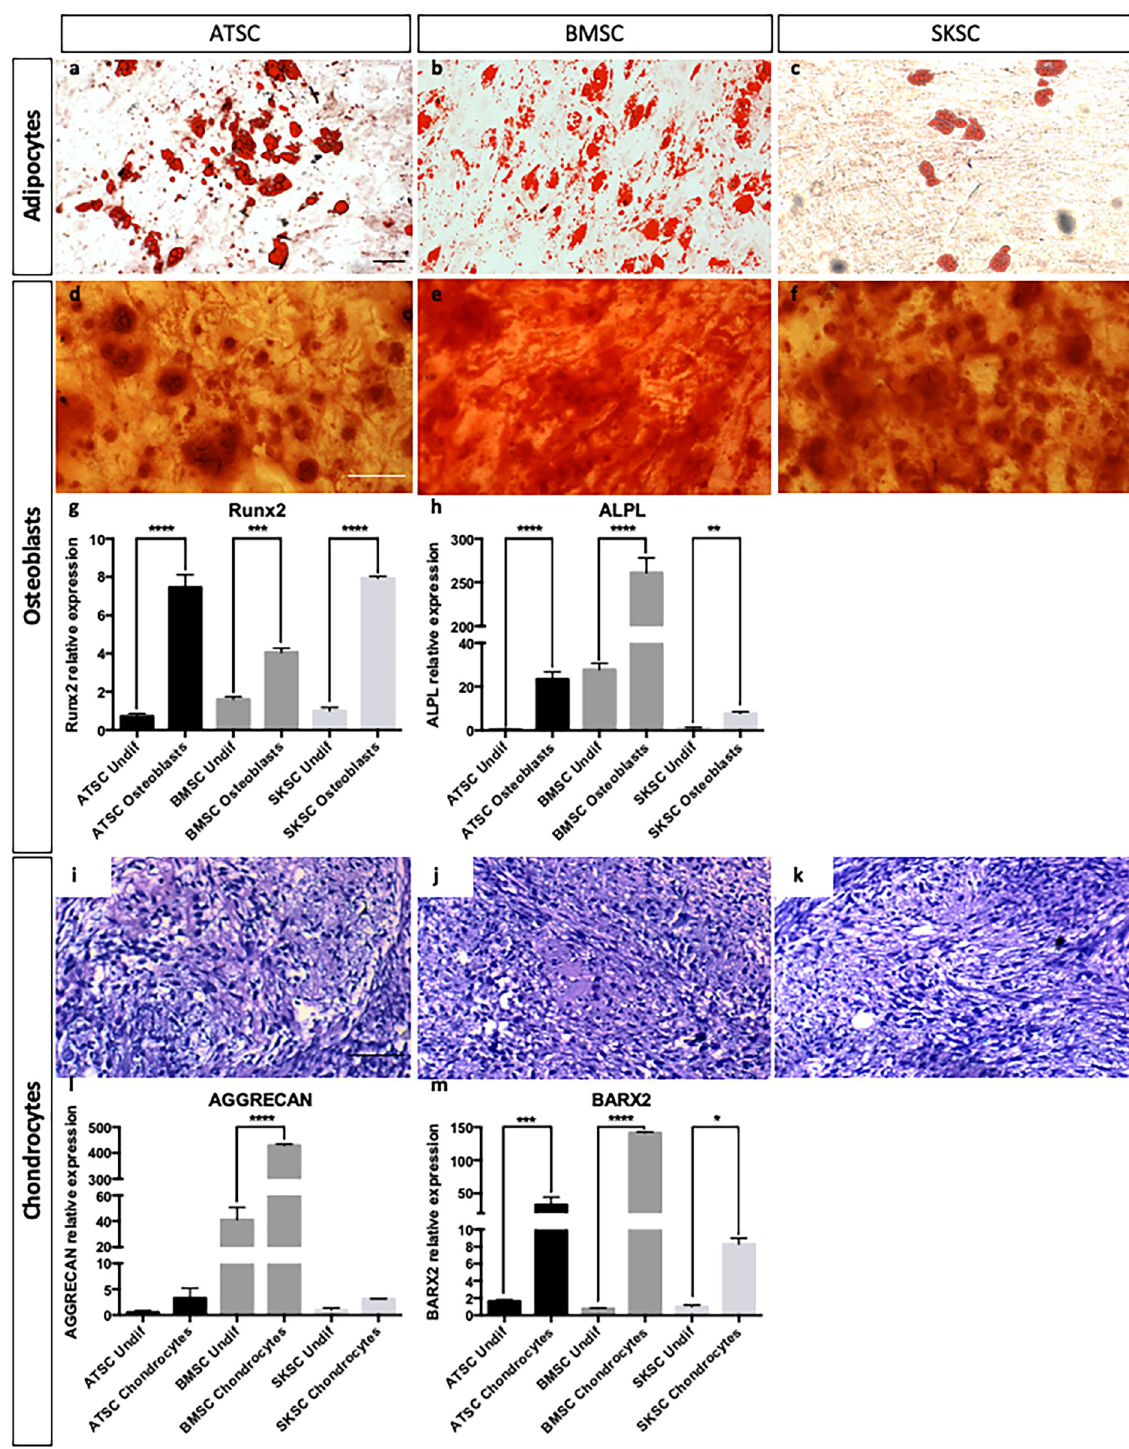
Fig 6. Differentiation abilities of human bone marrow, adipose tissue and dermis-derived stem cells. ATSC, BMSC and SKSC were able to differentiate into adipocytes (lipids vacuoles stained with Oil Red-O—a-c), osteoblast (calcium deposits stained with Alizarin Red—d-f), chondrocytes (chondrocyte matrix stained with Alcian Blue—i-k). Osteoblastic and chondrogenic differentiations were also assessed by quantitative RT-PCR based on RUNX2 (g), ALPL (h), AGGRECAN (j) and BARX2 (k) expression levels. Data were normalized to SKSC undifferentiated cells expression level set as 1. Statistical analysis: one way ANOVA followed by HSD post hoc test. � means p < 0.05, ��� means p < 0.0005, ���� means p < 0.0001. (Scale bars = 50 μ m).